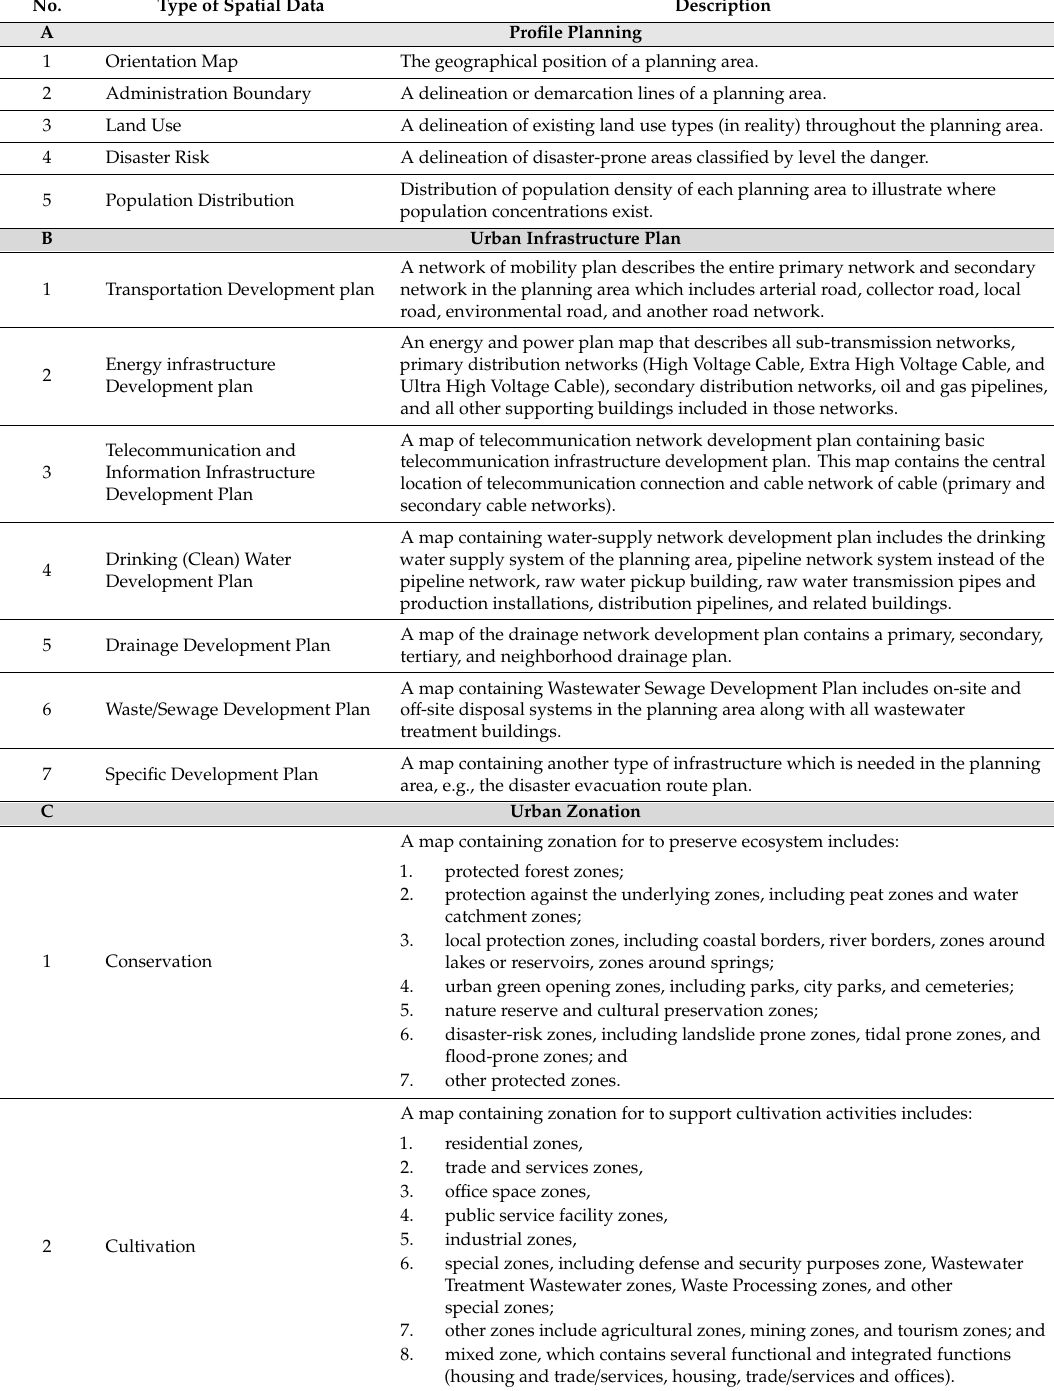
Table A2. List of urban zonation maps produced in the urban planning processes at map scale 1:5000 or better (Ministry of Public Works Regulation, 2011) which are produced by city